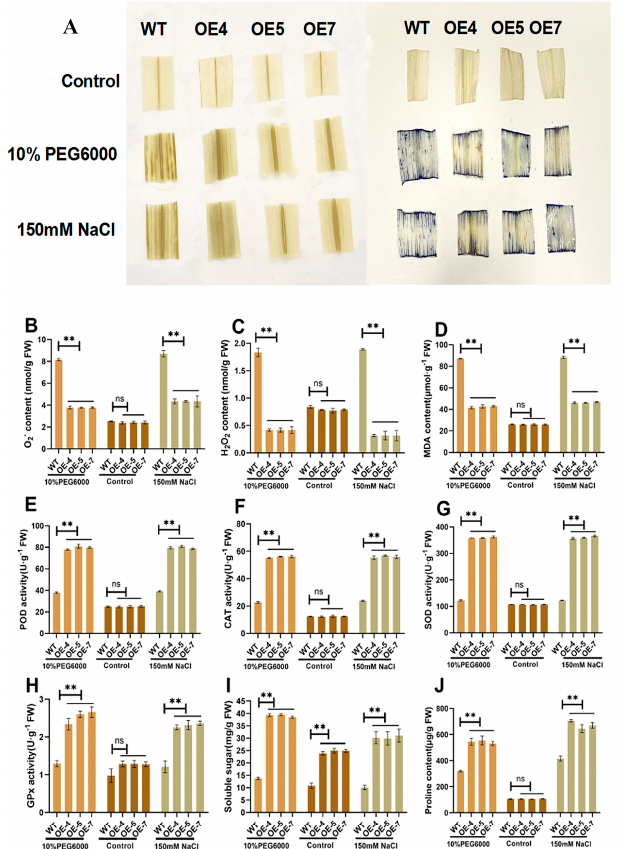
Figure 5. Oxidative stress of ZmSRG7 . ( A ) DAB and NBT staining. ( B , C ) O 2- and H 2 O 2 content analysis. ( D ) MDA content. ( E – H ) analysis of antioxidant enzyme activity (POD, CAT, SOD, GPx). ( I ) soluble sugar content. ( J ) proline content. Values are mean ± SD of three biological replicates. Bars with different letters are significantly different at p < 0.05 according to Duncan’s multiple range tests. p < 0.05 (**).